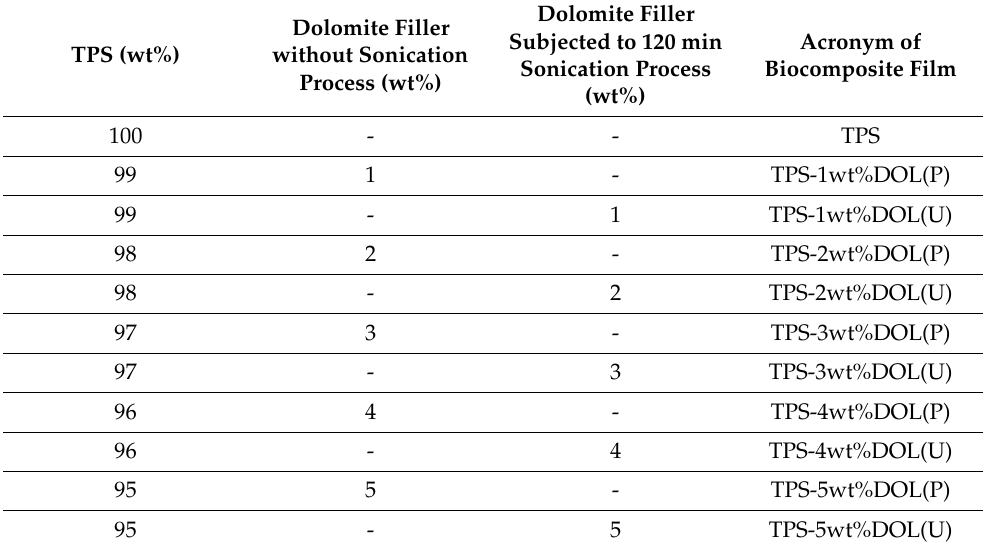
Table 1. The formulation of thermoplastic starch-dolomite (TPS-DOL) biocomposite films with their respective